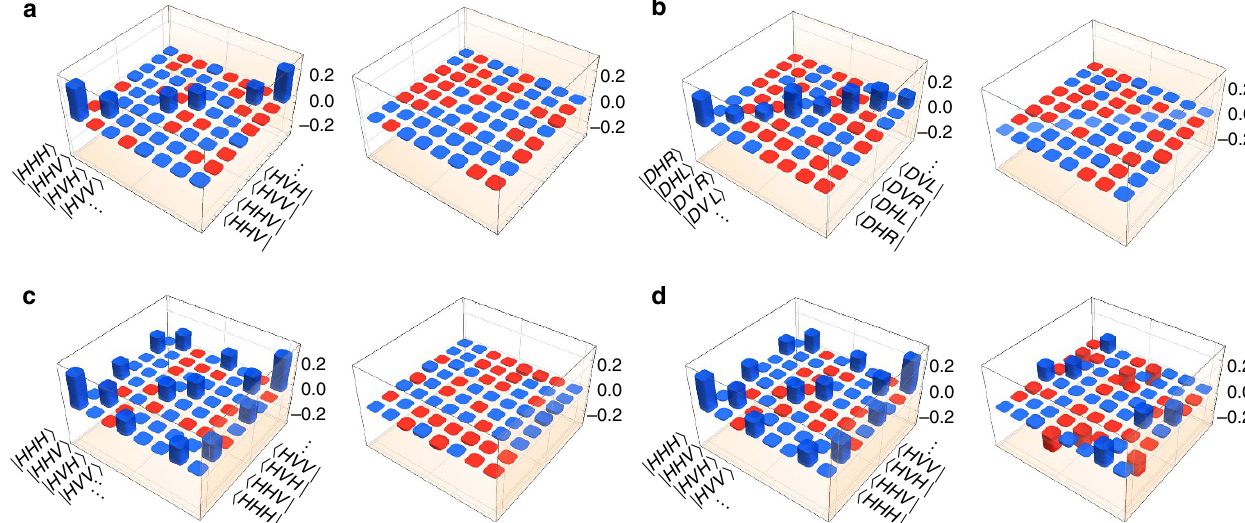
Figure 6 | Reconstructed causal maps. Reconstruction of the real and imaginary parts of the Choi state t CBD ¼ Tr FD 0 E BF j D 0 E (cid:3) E CD (cid:4) (cid:5) F þ j ið (cid:7) F þ h j D 0 D (cid:3) r CE Þ(cid:8) when targeting four combinations of cause-effect and common-cause mechanisms: ( a ) P ROB C, ( b ) P HYS C, ( d ) P ROB Q and ( d ) C OH . The causal maps for a , b are given in the local bases that diagonalize the target map, to make explicit their classical nature; no such bases exist for c , d . Blue (red) colour bars ph i 2 ffiffiffiffiffiffiffiffiffiffiffiffiffi represent positive (negative) values. The fidelities 30 , F (cid:2) Tr , to the theoretically calculated Choi state t th are high, at (98.1 ± 0.2)%, t 1 2 t th t 1 2 (98.06 ± 0.08)%, (97.1 ± 0.1)% and (93.7 ± 0.3)%, respectively, verifying that the experiment is performing as intended. Uncertainties on fidelities indiciate one s.d. and are estimated using Monte-Carlo simulations with Poissonian noise on photon counts. Notation for polarization states: H j i , horizontal, p p p p V j i vertical, D j i¼ 1 = ffiffiffi 2 H j iþ V j ið Þ diagonal, A j i¼ 1 = ffiffiffi 2 H j i(cid:5) V j ið Þ anti-diagonal, R j i¼ 1 = ffiffiffi 2 H j iþ i V j ið right-circular, L j i¼ 1 = ffiffiffi 2 H j i(cid:5) i V j ið Þ